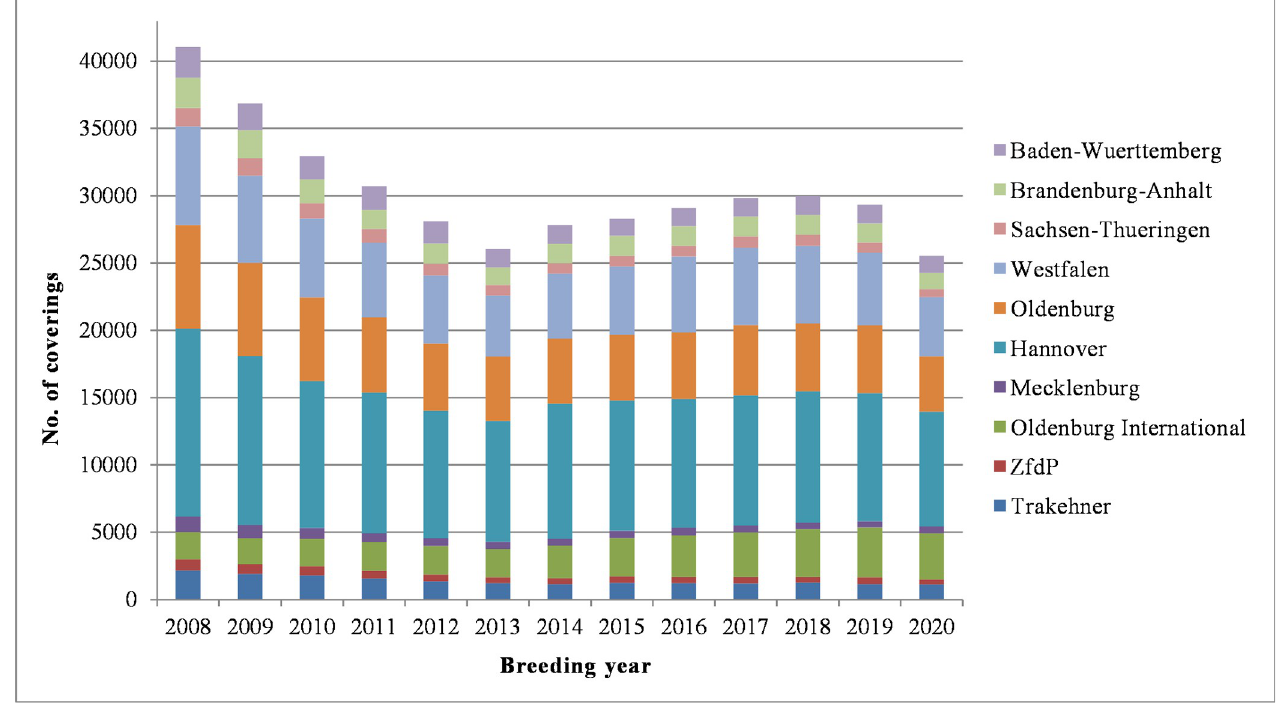
PLOS ONE | https://doi.org/10.1371/journal.pone.0267975 July 28,